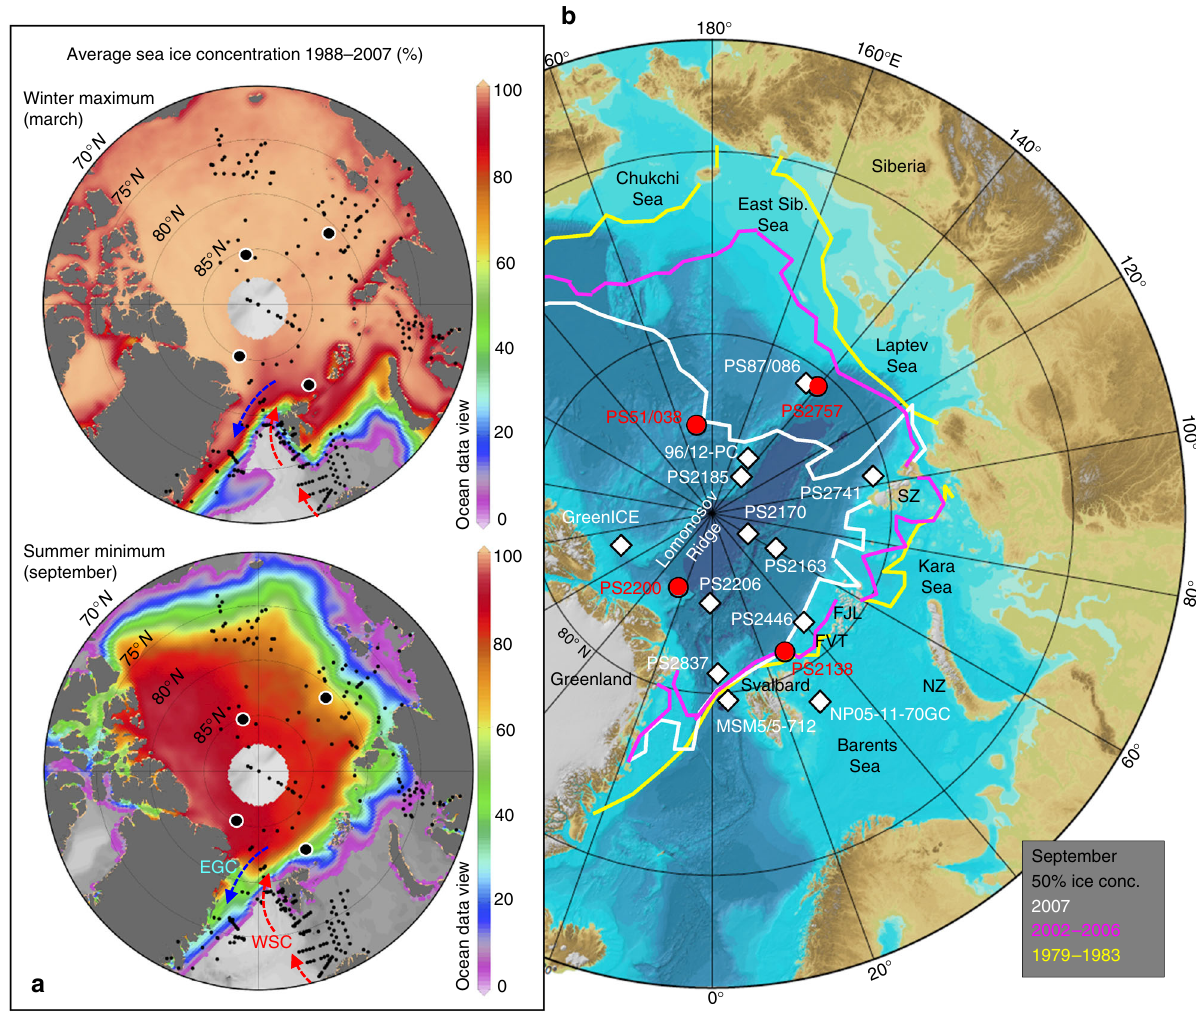
Fig. 1 Modern Arctic sea ice concentrations and location of sediments cores discussed in this study. a Average sea ice concentration 1988 – 2007 for March (winter maximum) and September (summer minimum) (Source: http://nsidc.org/). Small black dots show locations of surface sediment samples used for the IP 25 synthesis study of modern sea ice distribution 40 , the four large black circles show locations of the key cores used in this study. EGC = East Greenland Current; WSC = West Spitsbergen Current. Maps produced by software ʽ Ocean Data View ’ 75 . b IBCAO bathymetry map of the Arctic Ocean 76 with locations of sediments cores used in this study (cf., Supplementary Table 1). Red circles = key cores of this study; white rhombs = cores used for discussion. NZ = Novaya Zemlya; SZ = Severnaya Zemlya; FJL = Franz Josef Land; FVT = Franz Victoria Trough. The white , pink , and yellow lines show September 50% sea ice concentration for the years 2007, 2002 – 2007, and 1979 – 1983, respectively